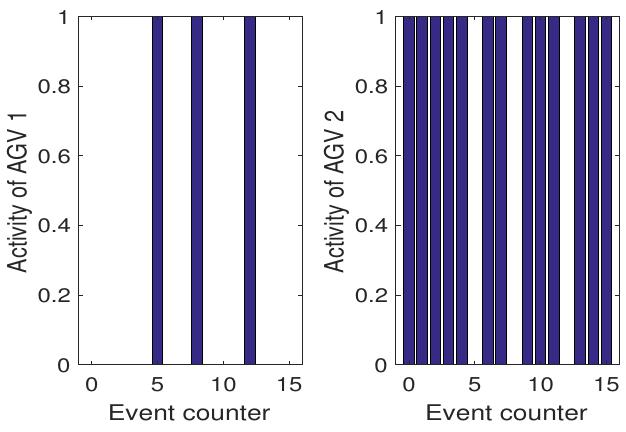
Figure 20. Scenario 3: Activities of